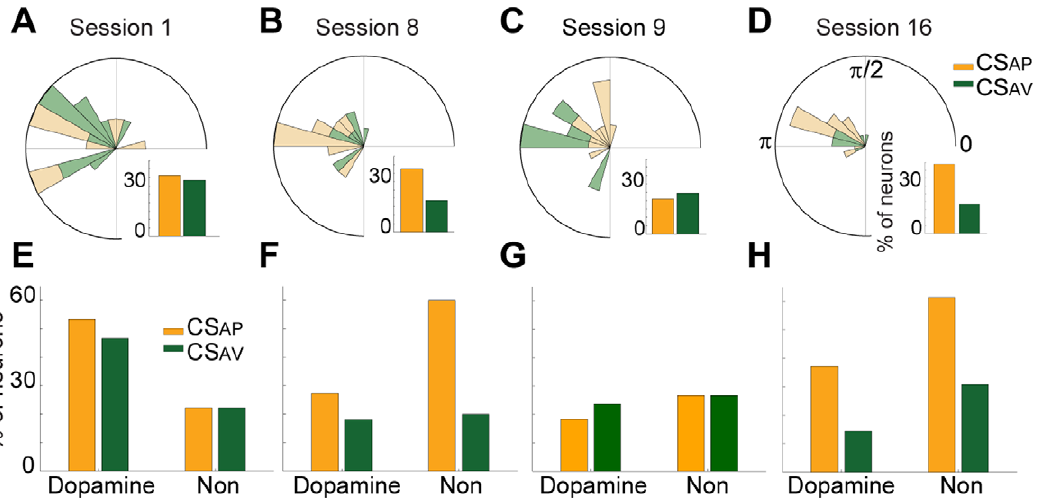
Figure 5. Phase locking of spike discharge to the theta rhythm. ( A–D ) Phase locking between neural discharge and LFP oscillations. Circular plots depict the number of units that were significantly phase-locked and the mean preferred angle of each unit in units of radians (bin size= p /12). Color legend is depicted at left of top row. Inset bar graphs depict the percentage of the units phased locked to the LFP theta rhythm during each CS. In session 1 ( A ), outer edge of circle inset=3 units. In session 8 ( B ), outer edge of circle inset=5 units. In session 9 ( C ), outer edge of circle inset=5 units. In session 16 ( D ), outer edge of circle inset=8 units. ( E–H ) Theta phase locking of putative dopamine and non-dopamine VTA units. The percentage of units phase locked to the theta oscillation during CS AP and CS AV presentation. Units were classified as putative dopaminergic or non-dopaminergic units. Data are presented with same conventions as insets from A–D.